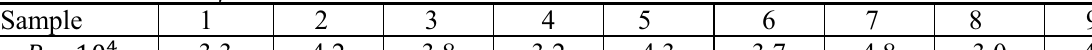
78(cid:24) (cid:17)